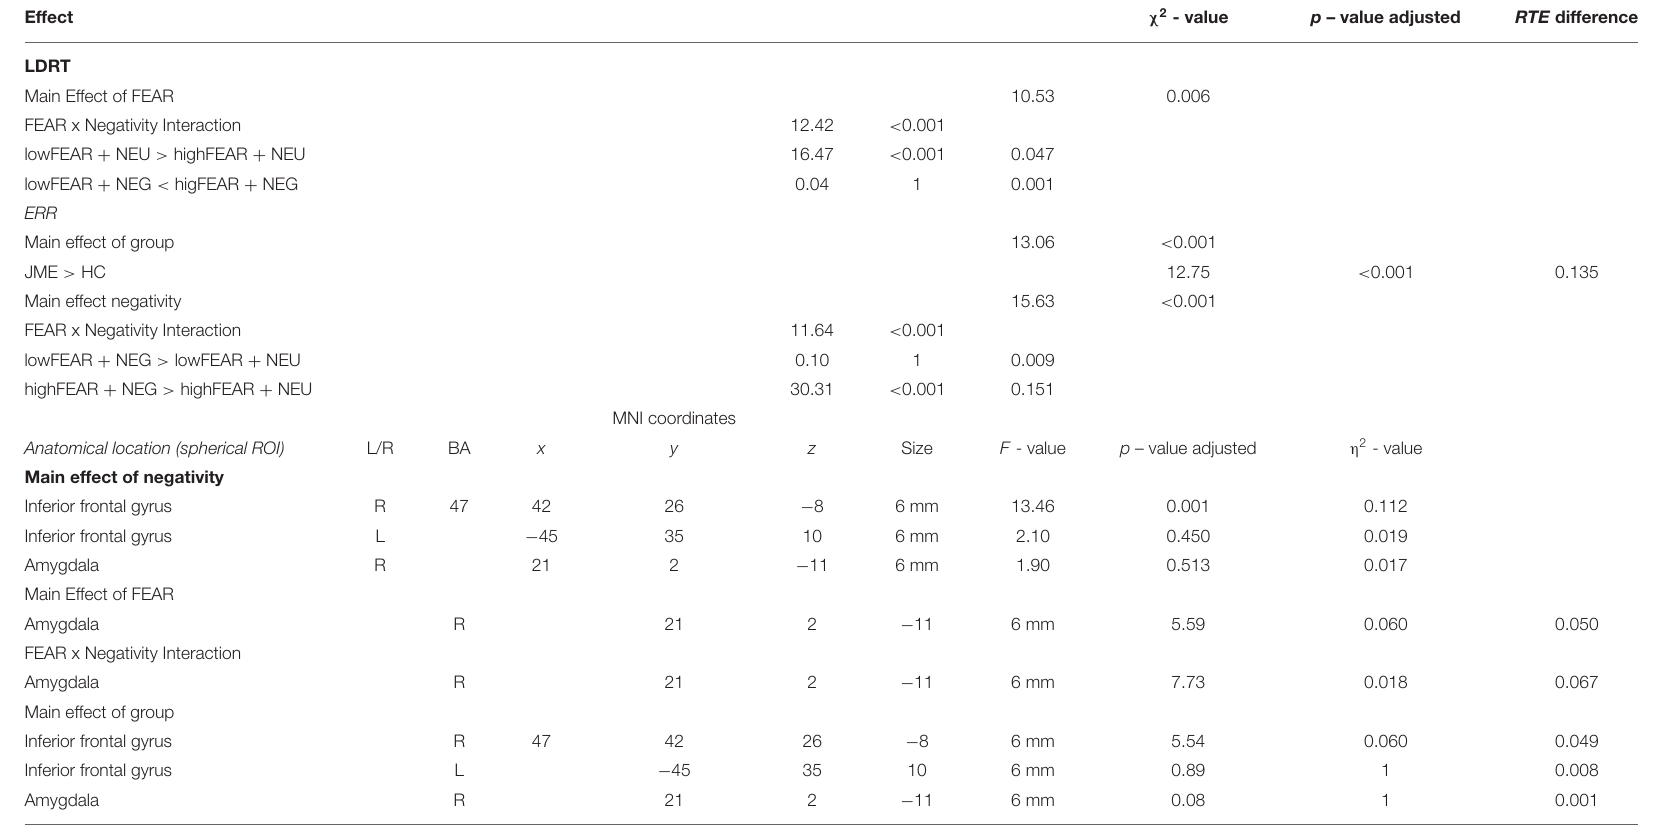
TABLE 4 | Statistical inference for the behavioral and fMRI